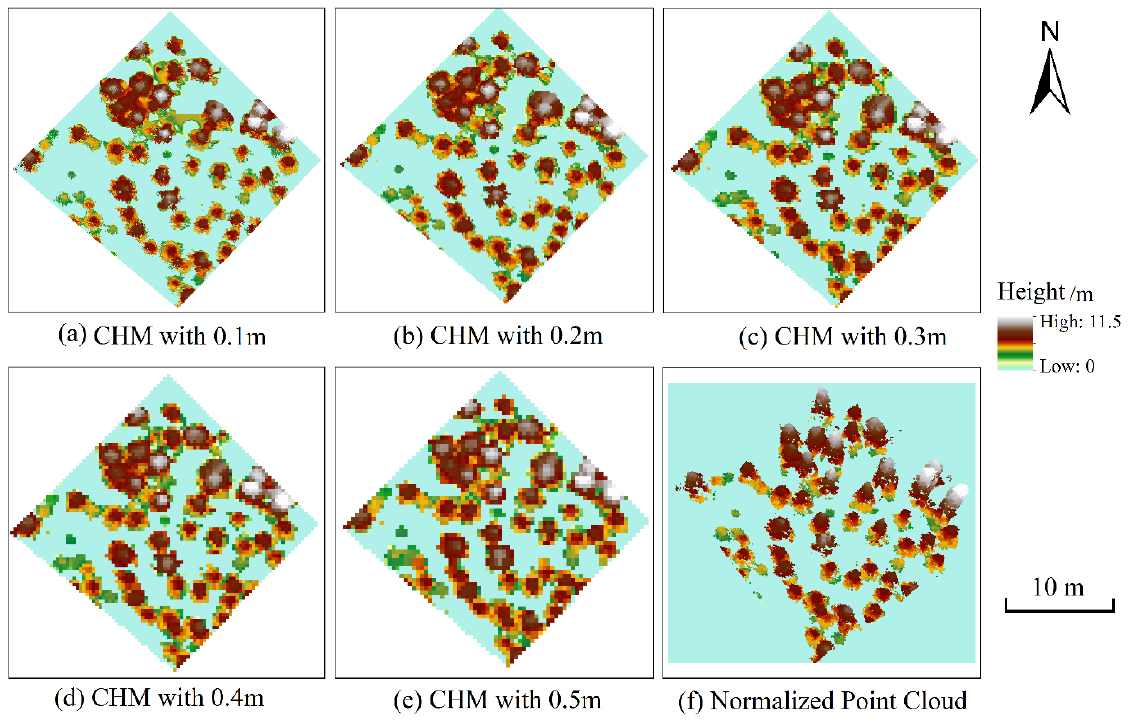
Figure 3. The NPC and CHM in plot